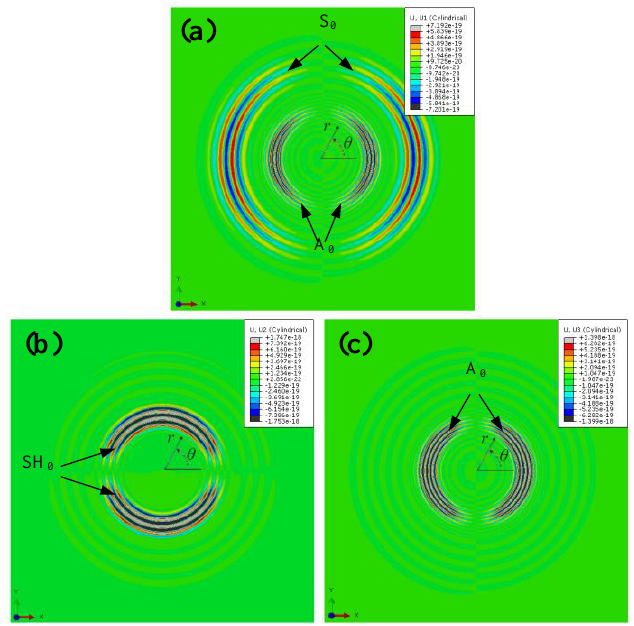
Figure 9. Images of the finite elementsimulation of the wave propagation in polar-coordinate instantaneous displacement is shown 76 µs after excitation. ( a ) Radial displacement, ( b ) tangential displacement and ( c ) out-of-plane displacement. Scale bars in meters.